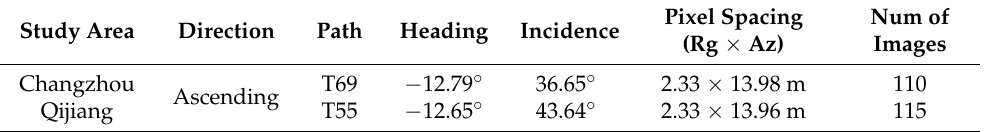
Table 1. The image parameters of the study areas. Study